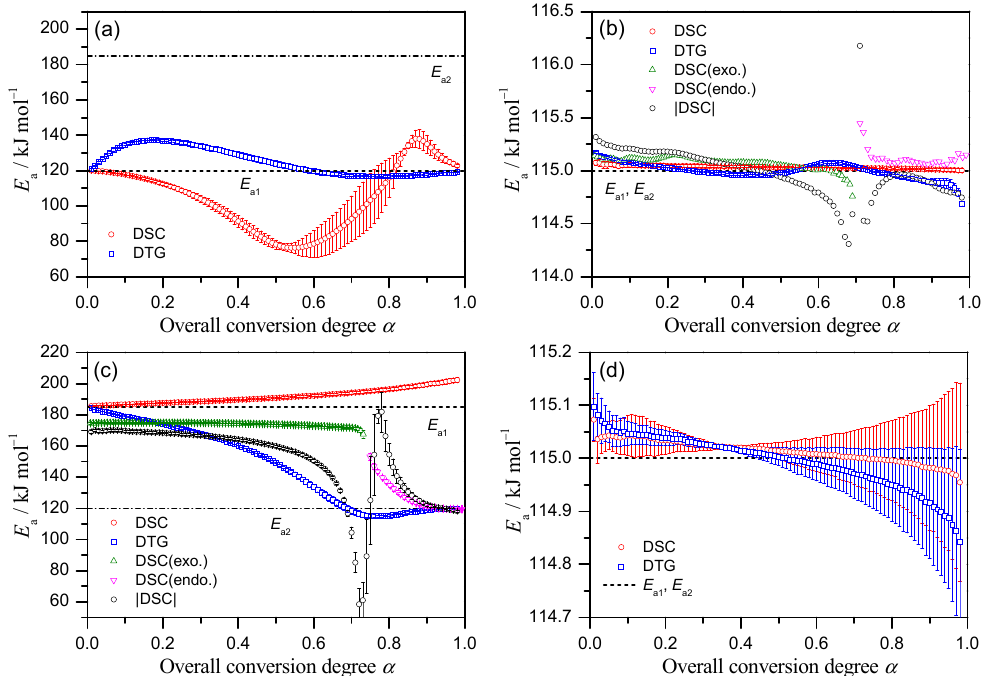
Figure 2. Isoconversional Friedman analysis of the simulated DTG and DSC data at β of 1–10 K min − 1 : ( a ) Case 1, ( b ) Case 2 (for clarity the uncertainties are not shown), ( c ) Case 3, and ( d ) Case 4.